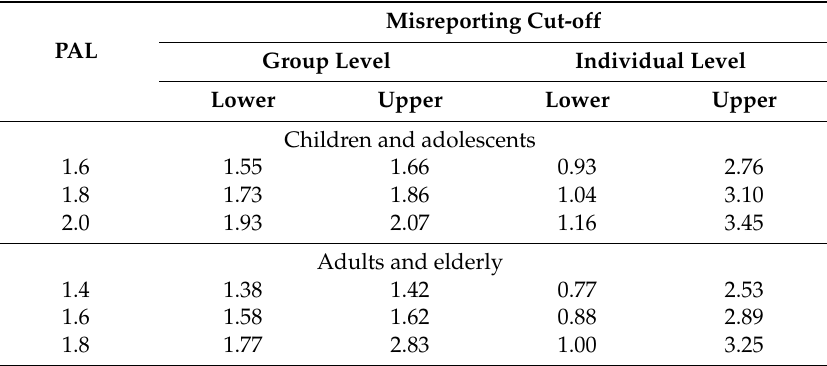
Table 1. Calculated misreporting cut-off at group and individual levels for the Anthropometry, Intake, and Energy Balance in Spain (ANIBES) study. Misreporting Cut-off PAL Group Level Upper